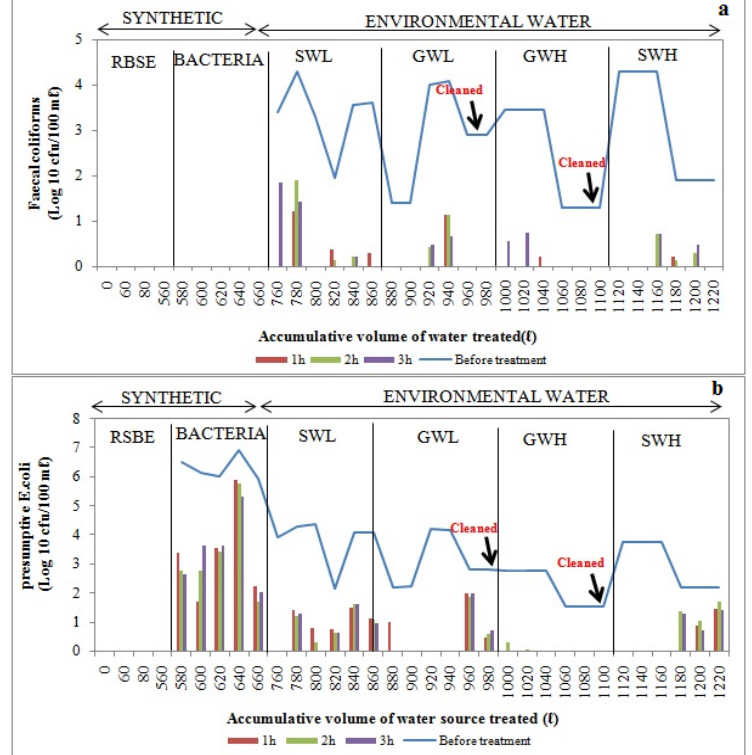
Figure 10. Log faecal coliform ( a ) and E.coli ( b ) concentrations in biosand filter-zeolite 10 before and after treatment of over 1 220 L of source water: synthetic water and environmental water samples (SWL, GWL, GWH and SWH). RSBE is the running of the system before the experiment, using deionised